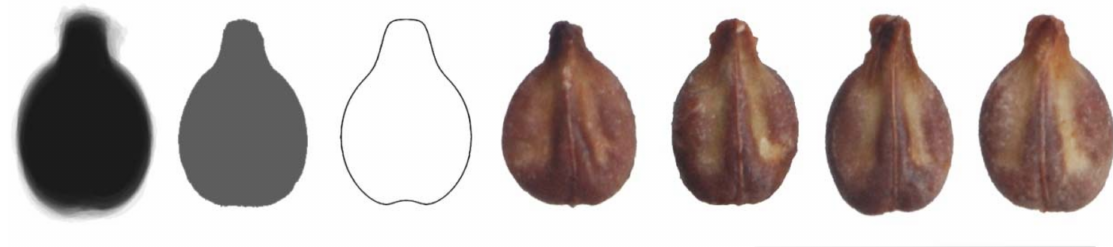
Figure 8. Albillo Real. From left to right: A sum of the silhouettes of 30 seeds of Albillo Real cultivar, a silhouette obtained by the pixel profile of the first image, the Albillo Real model, and four representative seeds of this cultivar. Bar represents 1